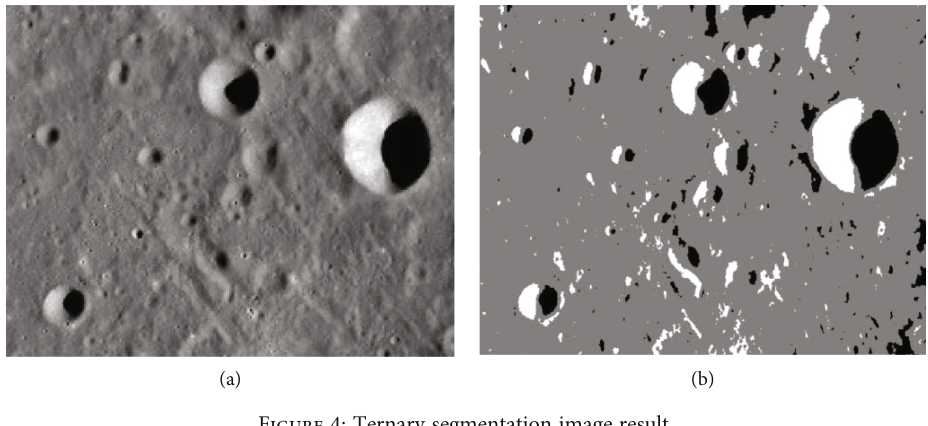
Figure 4: Ternary segmentation image result.